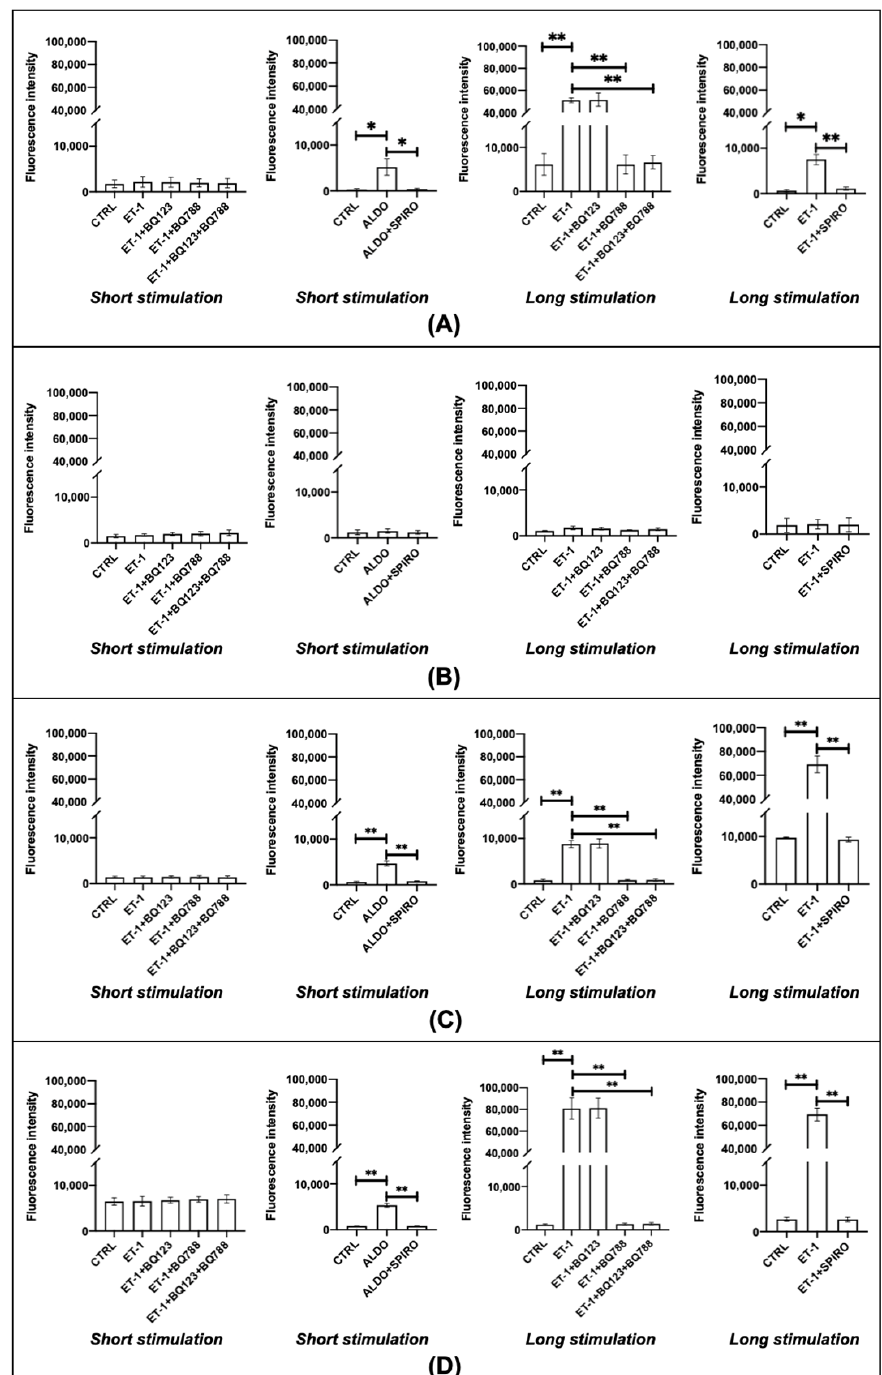
Figure 5. Oxidative stress evaluation in ( A ) HPFs, ( B ) HDFs, ( C ) lSScHDFs, and ( D ) dSScHDFs. All cells analyzed except HDFs produce ROS after a long ET-1 stimulation of 24 h and the antagonist of ETB (BQ788) or aldosterone (spironolactone) inhibits this effect; short aldosterone stimulation of 40 min is sufficient to promote oxidative stress. ROS production was evaluated by measuring the fluorescence intensity of CM-H2DCFDA. (** p < 0.005; * p < 0.05). (HPFs: human pulmonary fibroblasts; HDFs: human dermal fibroblasts; lSScHDFs: limited scleroderma dermal fibroblasts; dSScHDFs: diffuse scleroderma dermal fibroblasts; ET-1: endothelin-1; BQ123: ETA blocker; BQ788: ETB blocker; SPIRO: spiroronolactone).